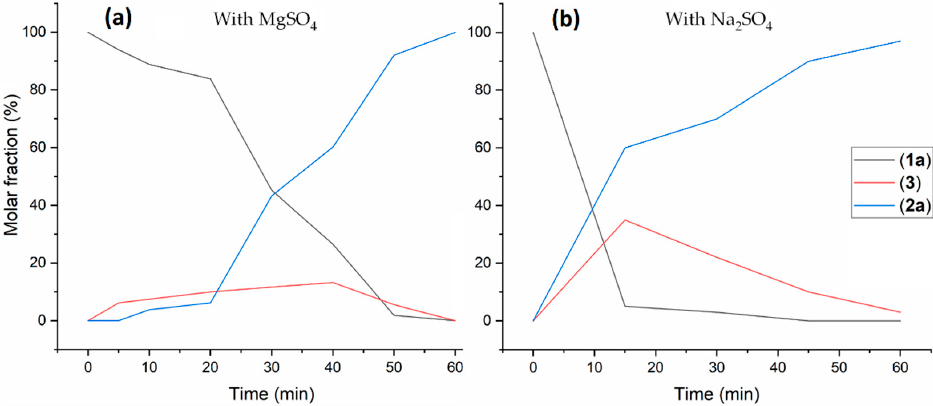
Figure 2. Monitoring the reaction of furfural with aniline using either MgSO 4 as drying agent ( a ) or Na 2 SO 4 as drying agent ( b ). Reactions were carried out using 1.3 mmol of furfural, 1.2 equivalent aniline, and 1.3 mmol of drying agent in 7 mL i PrOH.